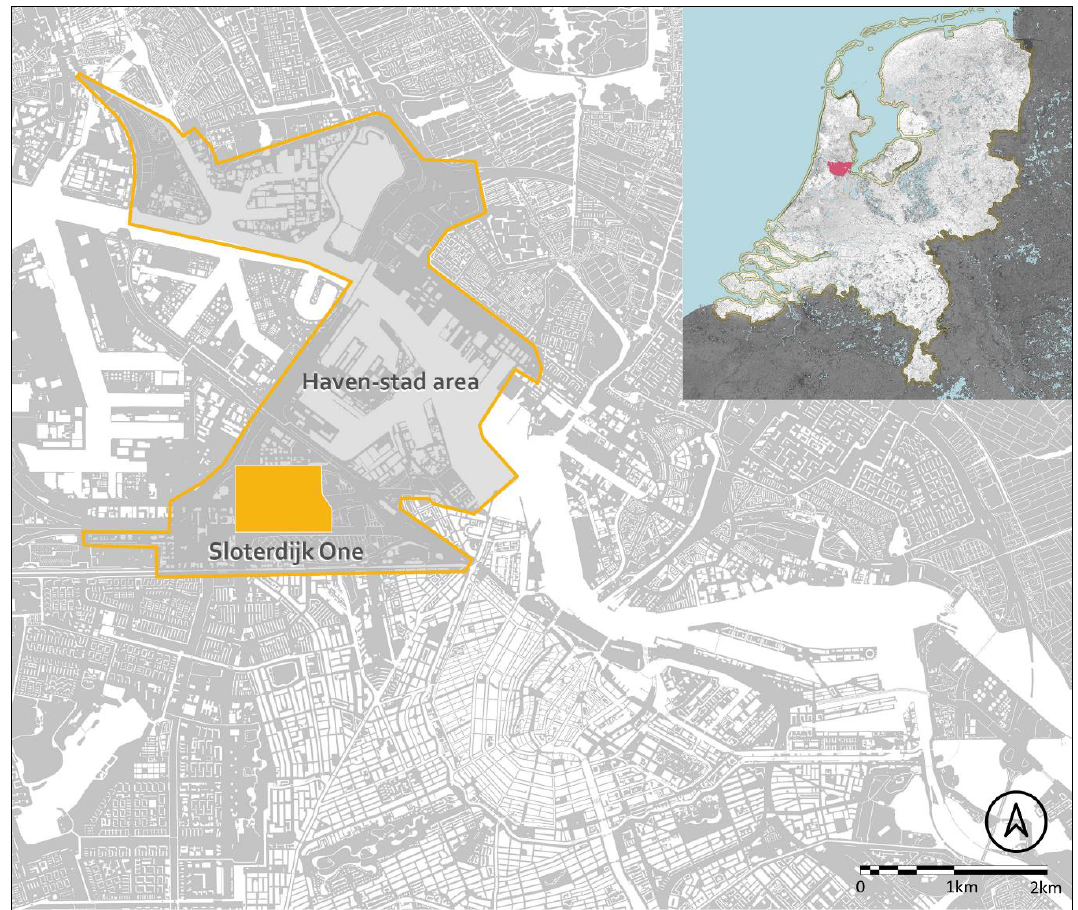
Figure 1. The case study area “Sloterdijk One”, located within the Haven-Stad project area in the western part of the city of Amsterdam. The smaller image on the top right corner shows the size and location of Amsterdam in the Netherlands.